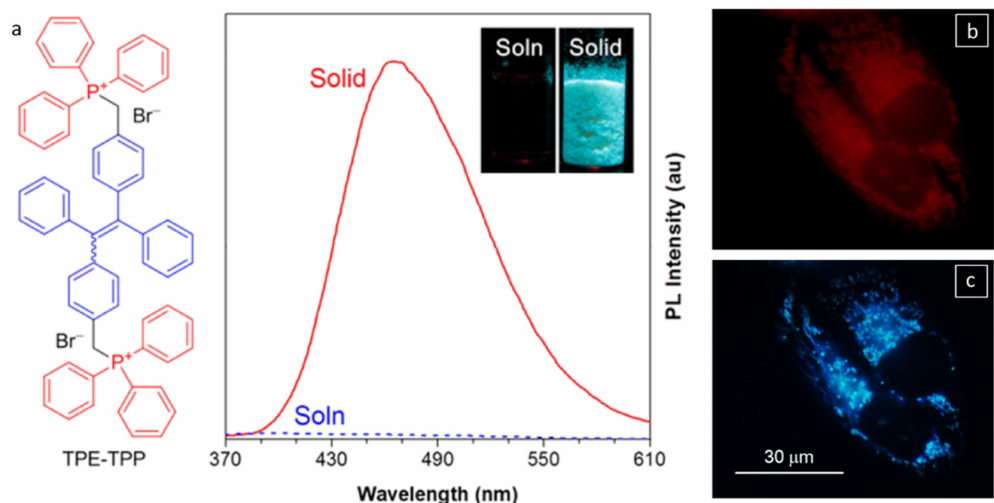
Figure 6. ( a ) Molecular structure of TPE-TPP; photo-luminescence spectra of TPE-TPP in solid and solution states. Inset: Photographs of a DMF solution (left) and a solid powder (right) of TPE-TPP taken under UV radiation. Concentration of TPE-TPP = 10 µ M; λ ex = 321 nm. Fluorescent images of CCCP (10 µ M) treated HeLa cells stained with ( b ) MT (50 nM) for 15 min and ( c ) TPE-TPP (5 µ M) for 30 min. λ ex = 540 − 580 nm (for MT) and 330 − 385 nm (for TPE-TPP). Reprinted (adapted) with permission from [57]. Copyright (2013) American Chemical Society.